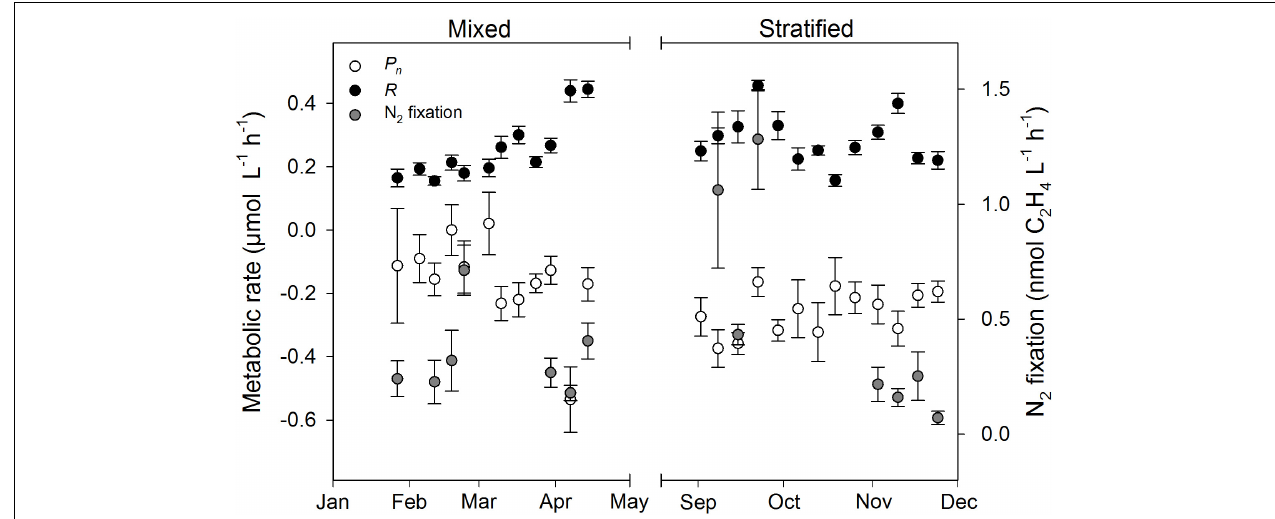
FIGURE 2 | Planktonic primary production and N 2 fixation rates measured weekly at 10 m water depth (1 m above the benthos) during the mixed and stratified periods. Net photosynthesis ( P n ), dark respiration ( R ). Values given as mean ± SE.